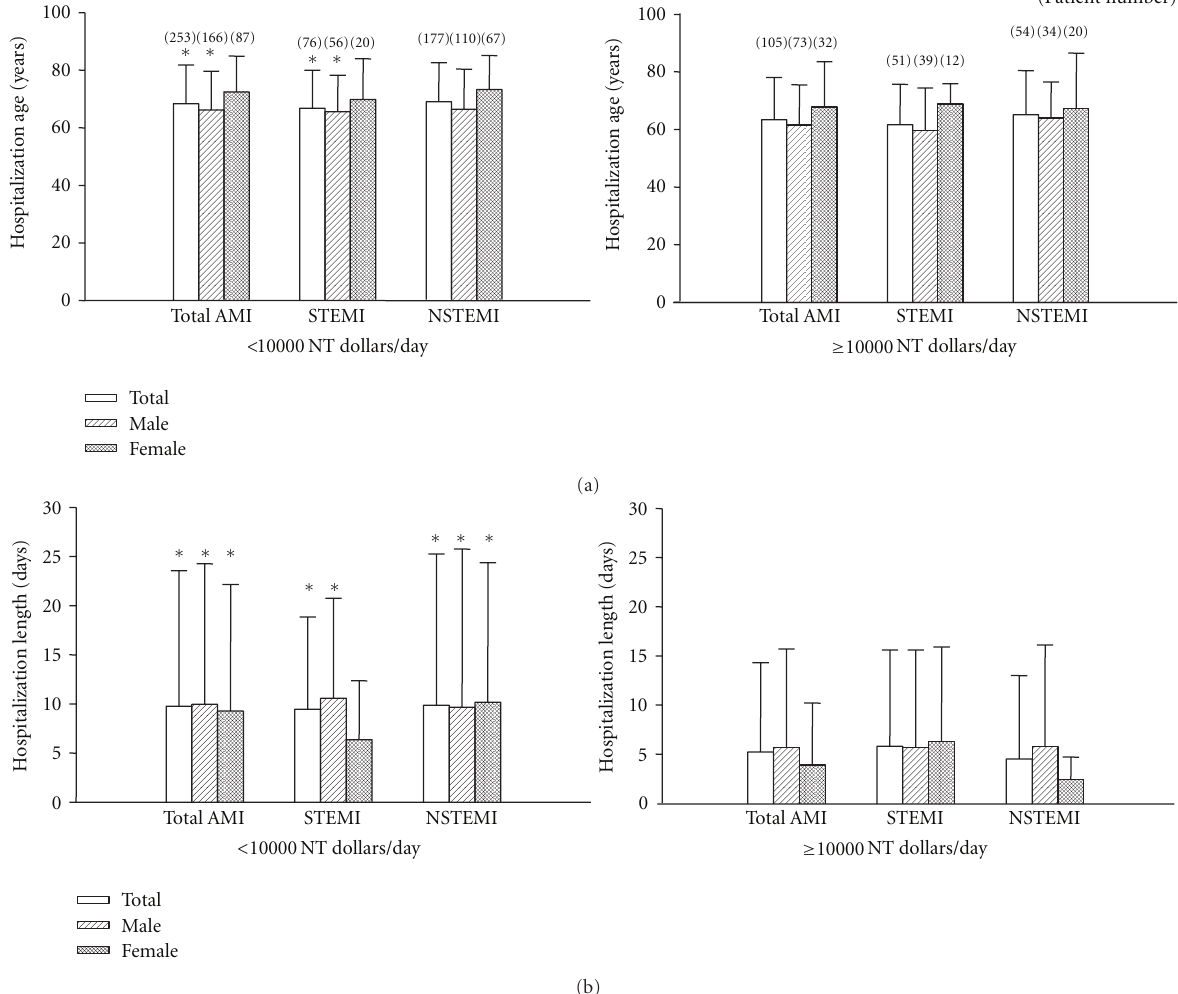
Figure 5: Hospitalization age and lengths in higher ( ≥ 10000 NT dollar/day) and lower cost AMI patients from 1999 to 2008. Panel (a) shows the average age from higher and lower AMI hospitalization cost. Panel (b) shows the average hospitalization lengths from higher and lower AMI hospitalization cost. ∗ P < 0 . 05 versus higher cost patients ( ≥ 10000 NT dollars/day). Only the patients with first onset AMI within the year were included.